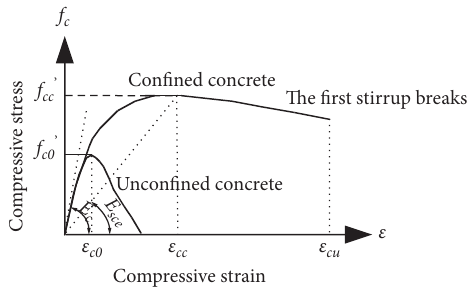
Figure 3: Envelope curve of Mander’s confinement model.